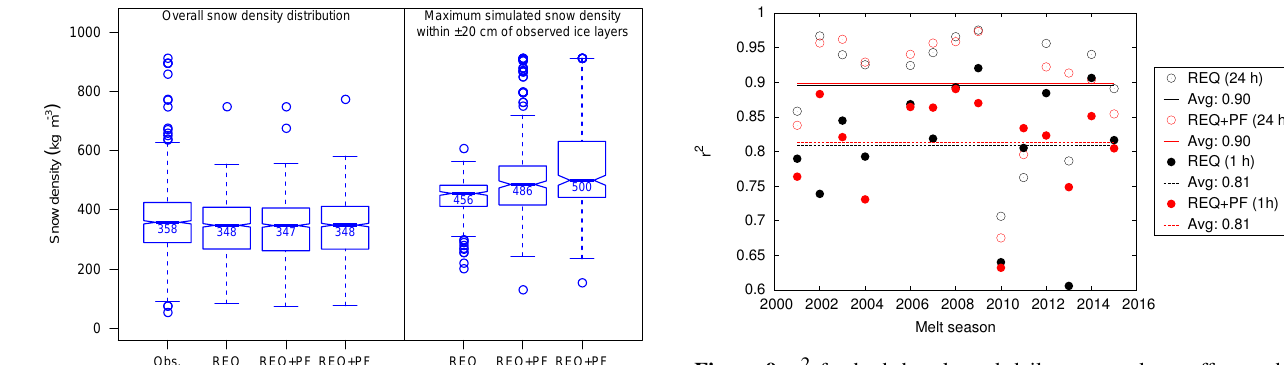
Figure 9. r 2 for both hourly and daily snowpack runoff over the period 1 March to 31 May for each snow season. Figure 10. Difference (in days) between modelled and measured first 10 and 20mmw.e. cumulative seasonal snowpack runoff (neg- ative values denote modelled runoff is earlier than measured